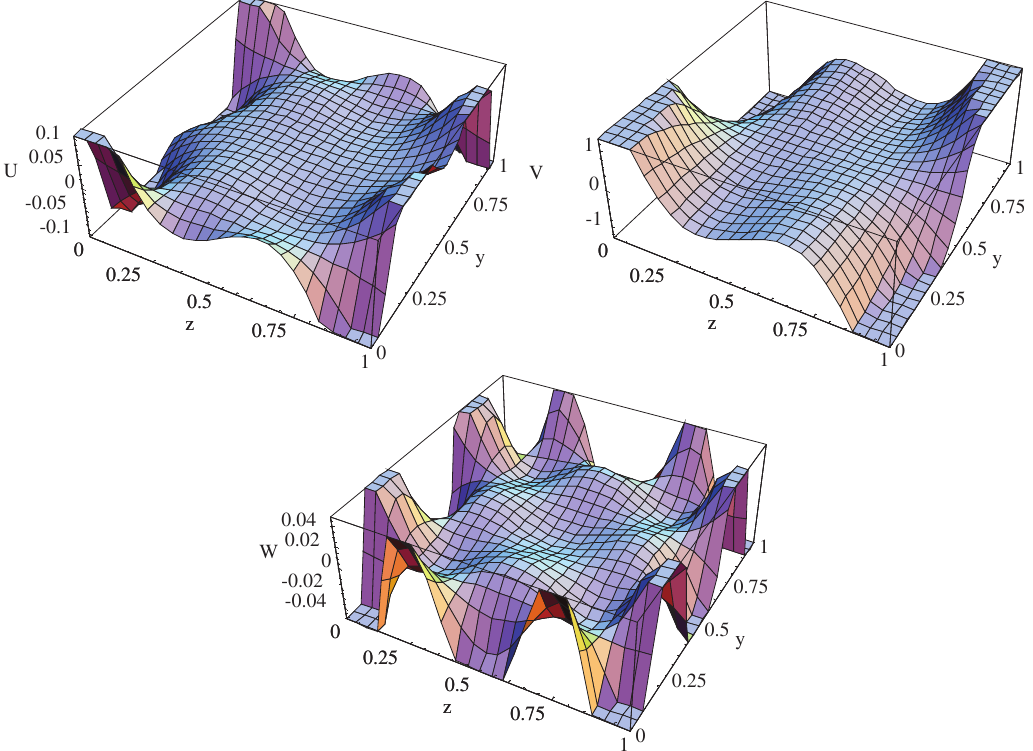
Figure 8: Displacement shapes of the fourth mode for the sinusoidally FGPP square bar at kd = 90.1.